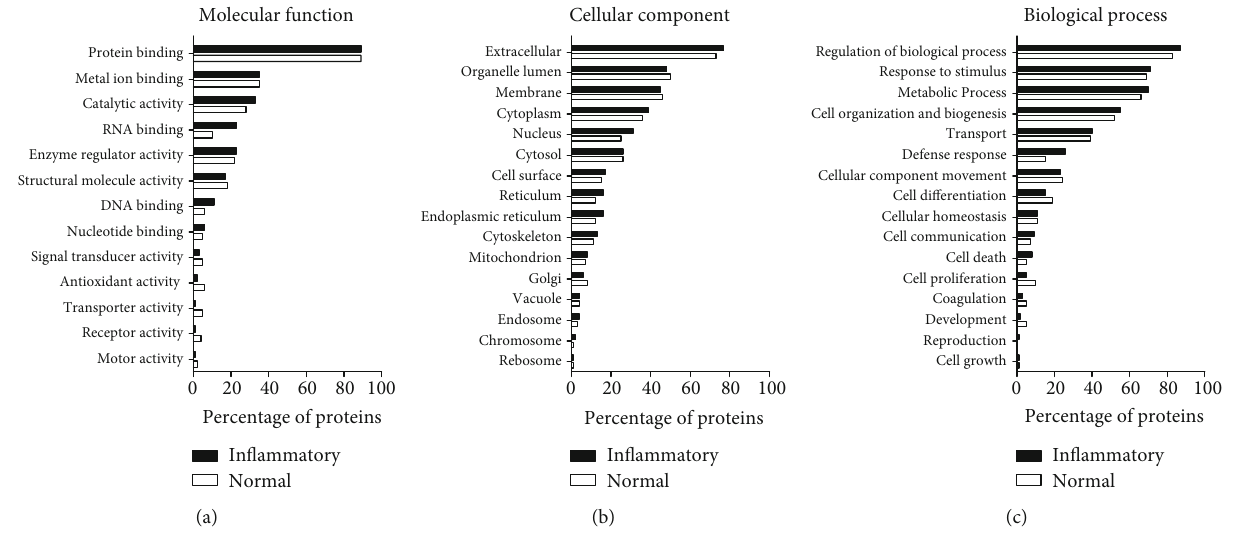
Figure 3: Gene Ontology (GO) annotation analysis of the commonly secreted proteins by all mesenchymal stem cells (MSCs) under normal and in fl ammatory conditions: (a) molecular function; (b) cellular component; (c) biological